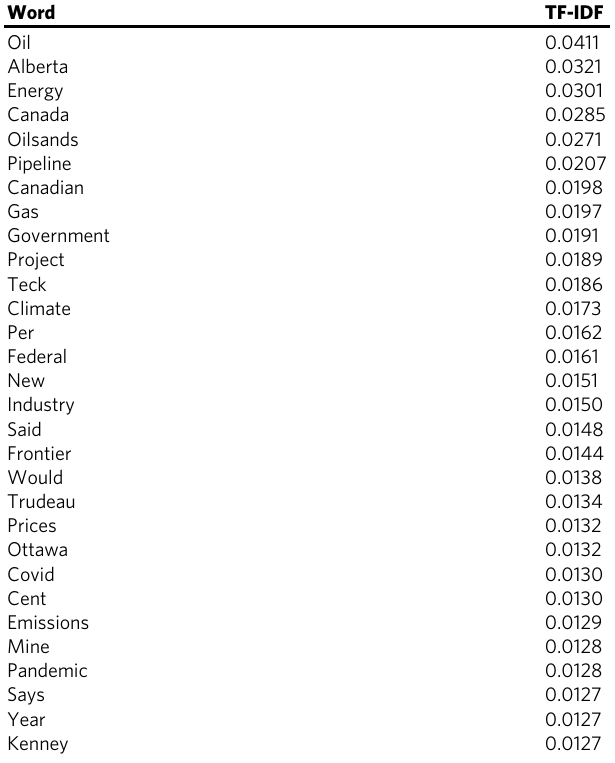
Table 1 Top 30 keywords of the abridged